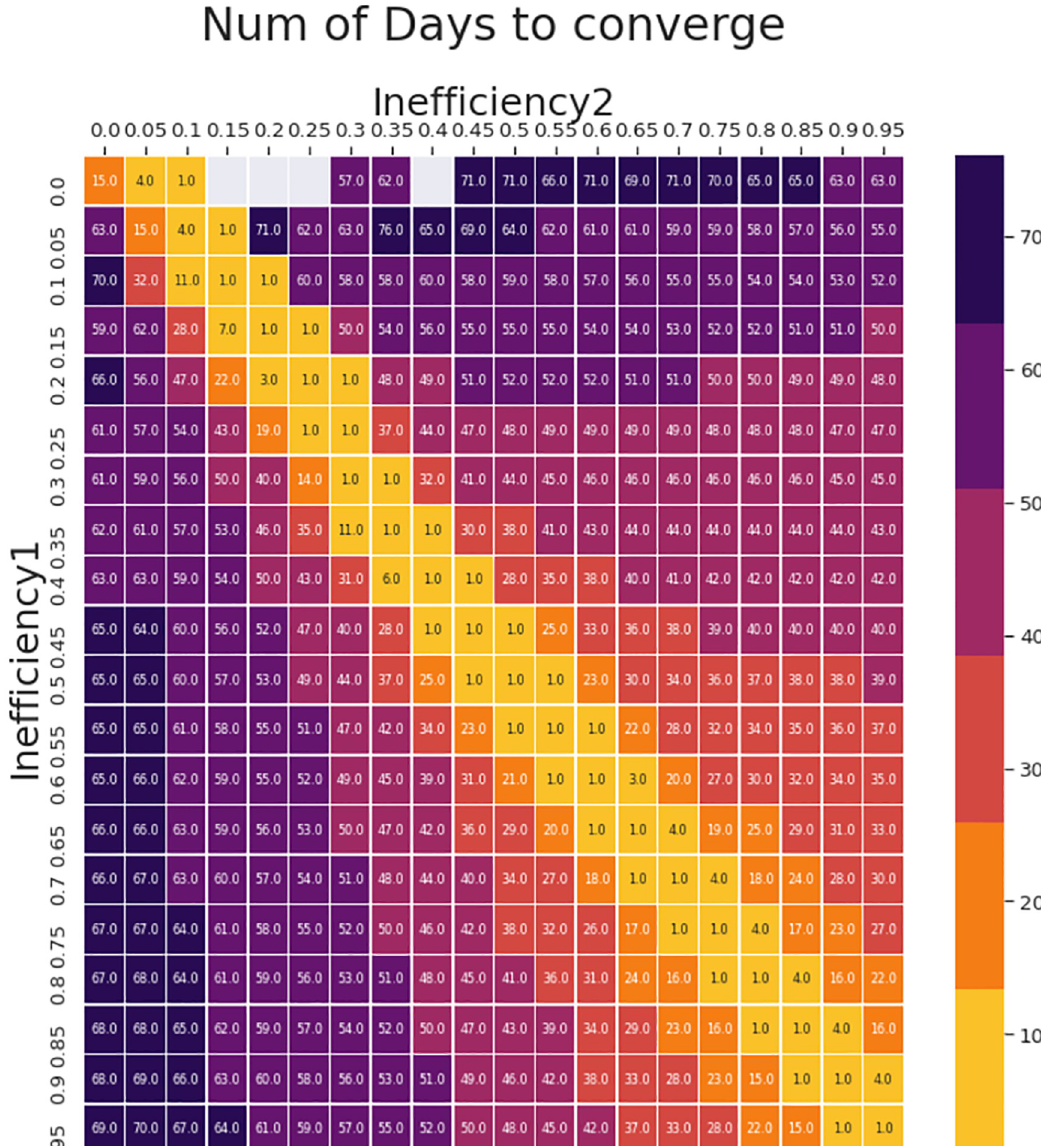
Fig 3. Correlation between intervention Inefficiency 1 , Inefficiency 2 when D smooth ratio is calculated over a 50 day window and the number of days for D smooth ratio to converge with Inefficiency 2 is plotted on a heatmap. The days to converge is the least on the diagonal and is largely symmetric. Transitions in the range of inefficiencies 0.2 through 1 converge within a period of 60 days and the range from 0.4 through 1 within 50 days. The empty(grey) cells indicate it takes more number of days to converge than the period of simulation or the cases are extremely low to show up in the D smooth ratio . In general it may be seen that in the high inefficiency range where it is critical to react fast, the convergences are faster, thus emphasizing the utility of this metric.